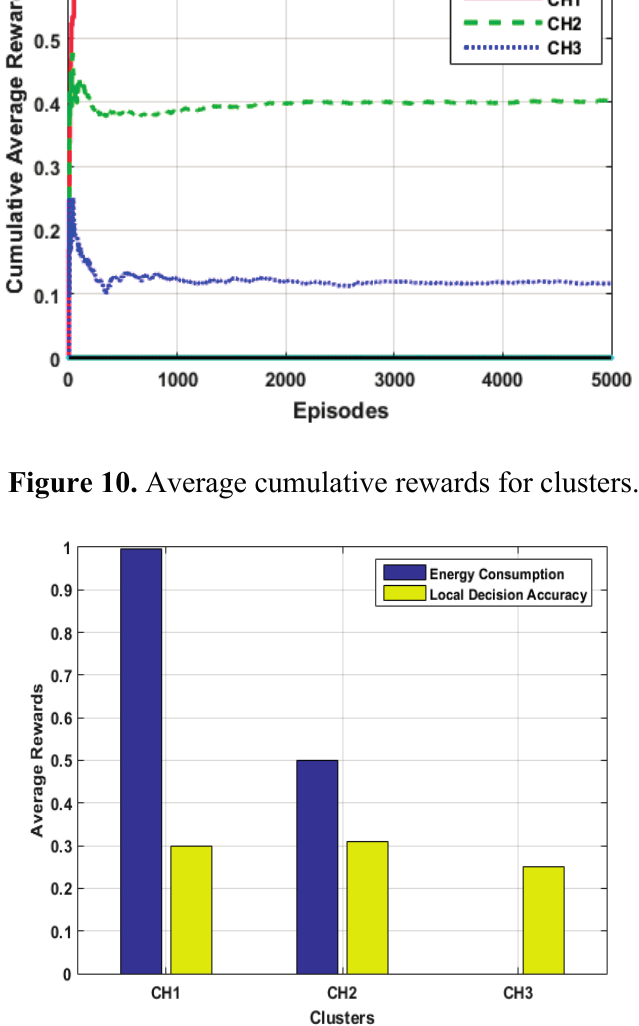
Figure 11. Average rewards for energy consumption and local